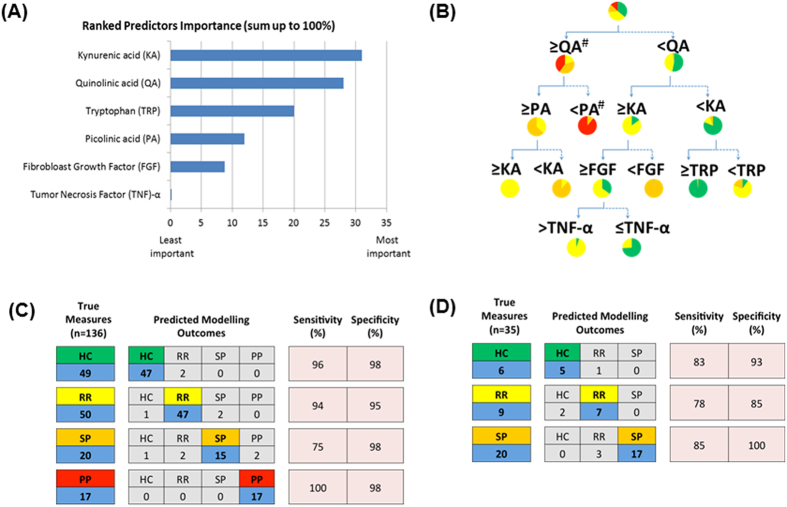
Biomarker for predicting MS severity using in silico approach.(A) Classification modelling was based on exploratory analysis on the variables in the dataset with the shortlisted six predictors, i.e., QA, PA, KA, FGF-basic, TRP and TNF-α and its ranked importance for the predictive analytics. (B) Training Set using a C5.0 Decision Tree comprised of pie chart proportions of healthy control or MS subtype after being split by the six predictors. To optimize the split, calculated cut-off concentrations for each predictor were determined by the analytic software. The aim is to define a set of predictors that results in a full circle for each experimental group. For example, a QA concentration ≥494 nM (#) results in isolation of the SP and PP MS subtypes, then applying a PA concentration of <313 nM (#), as the next predictor, results in 89.1% isolation of the PP MS subtype. The experimental groups are denoted: healthy control (HC; green), RRMS (RR; yellow), SPMS (SP; orange) and PPMS (PP; red). (C) The numbers of observed and correctly predicted HC and MS subtype in the Training Set are shown (blue boxes) along with proportions of true (sensitivity) and false (specificity) predictions. (D) A different Test Set was used to validate the predictive model built from the Training Set. The numbers of observed and correctly predicted HC and MS subtype in the Test Set are shown (blue boxes) along with proportions of true (sensitivity) and false (specificity) predictions.